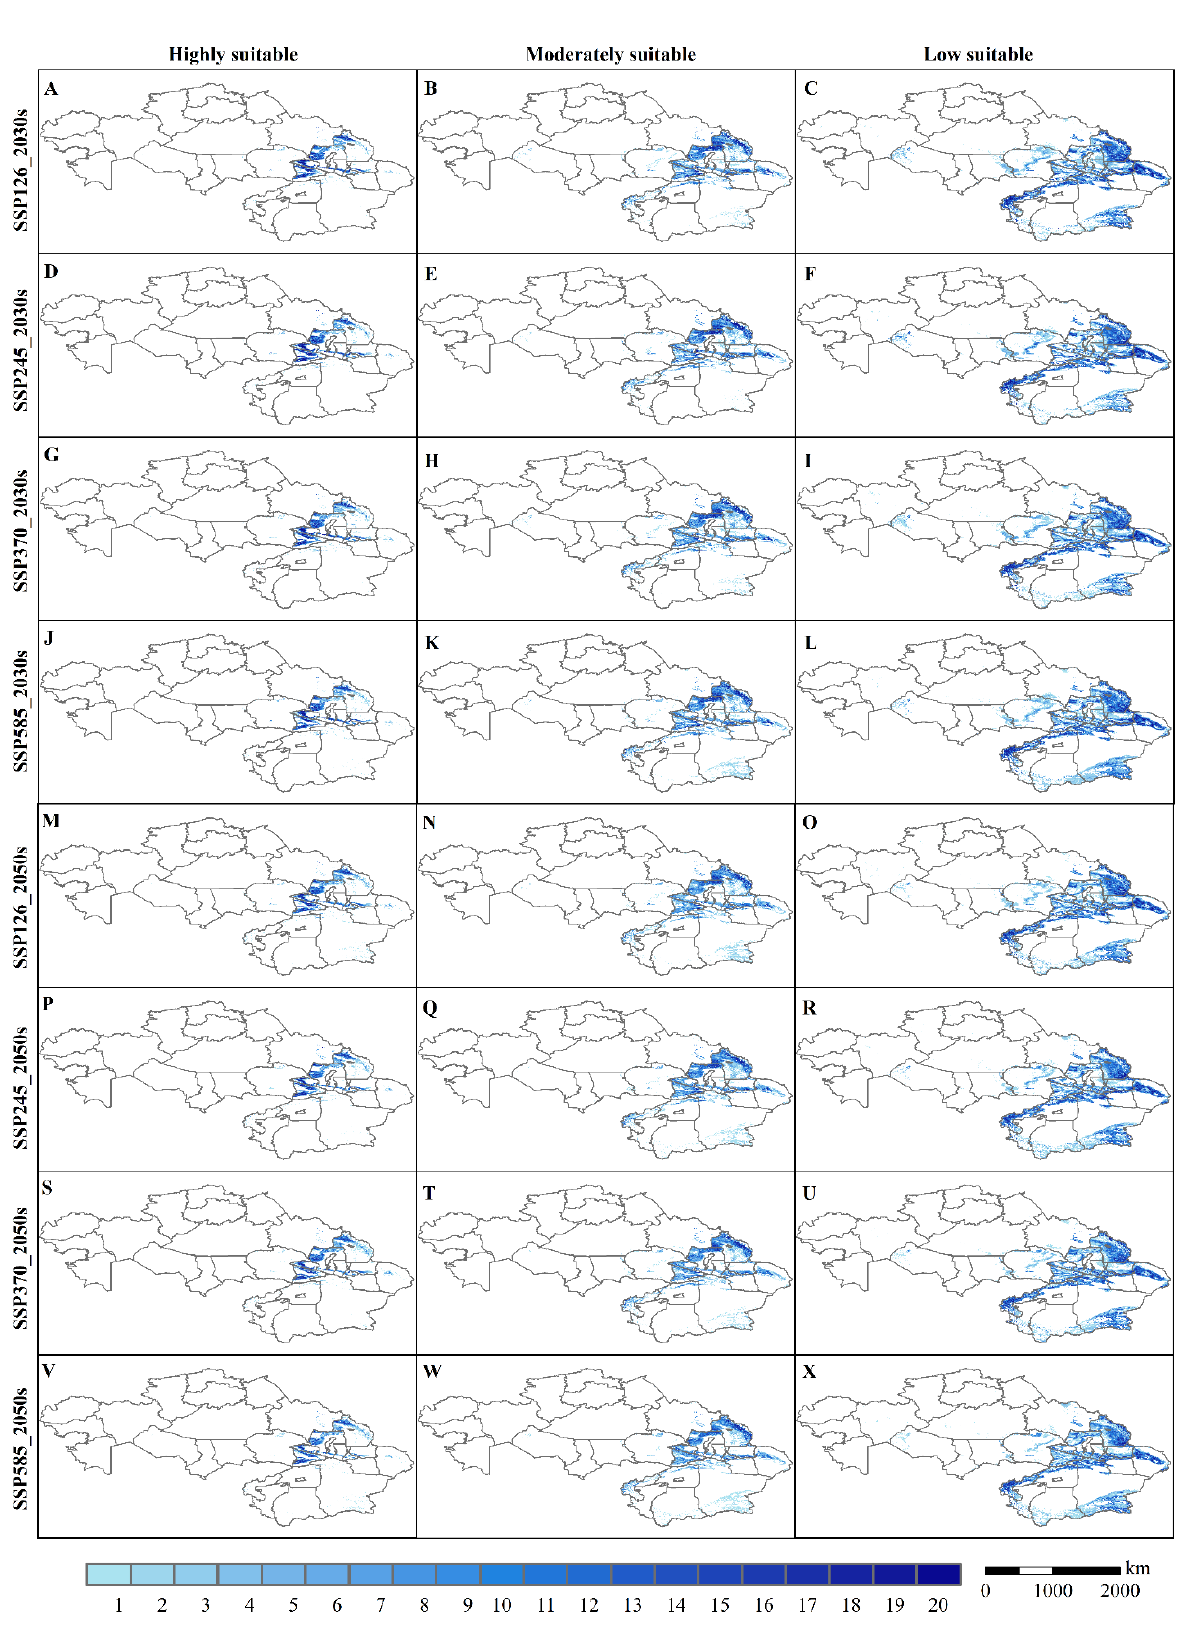
Figure 8. ( A – X ) Consensus map of suitable areas for typical locusts in the 2030s and 2050s based on climate data for 20 GCMs. The values (1–20) indicate the number of voting consensuses. Larger values indicate higher consistency of simulation results.